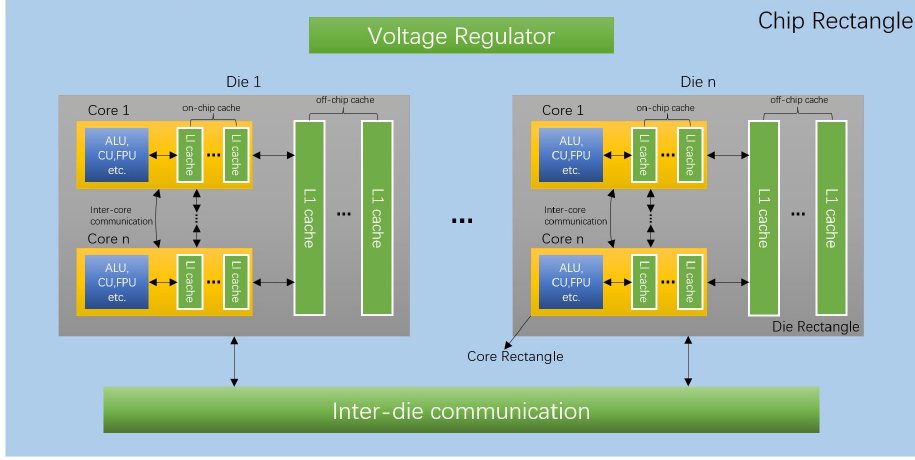
Figure 1. The general architecture of a multi-core